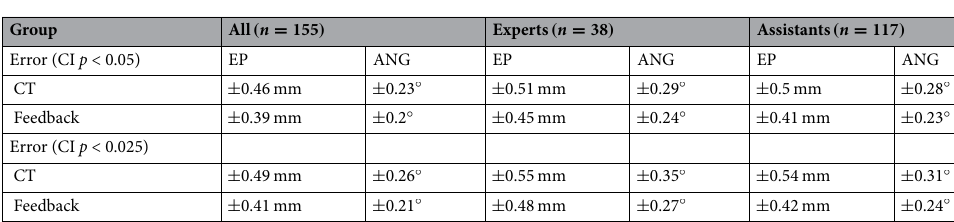
Table 3. The least EI of the TOST to reach the CI P < 0.05 , and P < 0.025 (the adjusted CI using